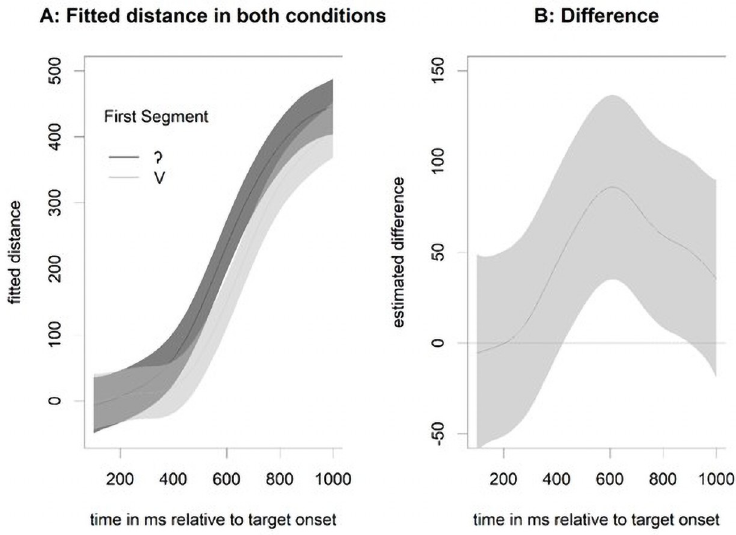
Fig 3. Outcome of the general additive model for target preference comparing vowel-initial words with glottal stop-initial words.